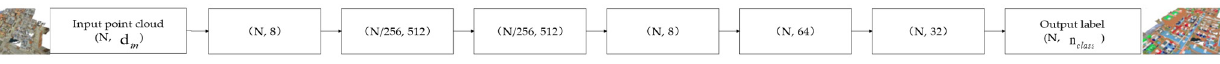
Figure 8. The effect of point cloud mapping.